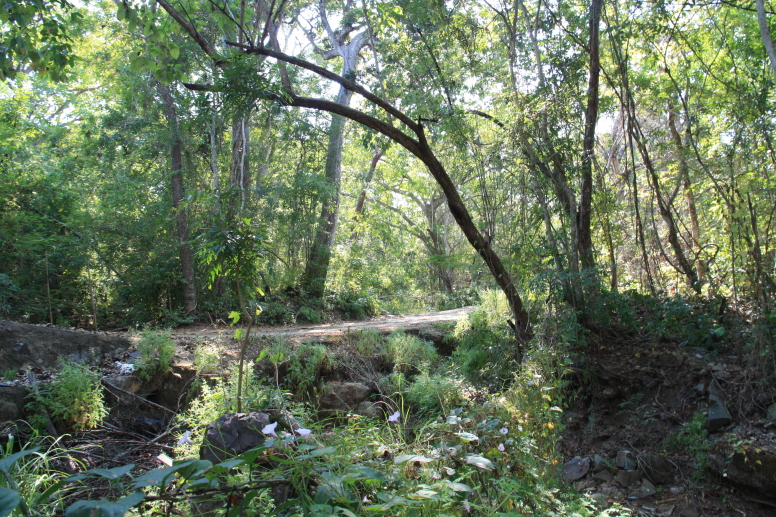
Brachypelma
boehmei habitat, subtropical dry forest and thorn brush, north of Ixtapa, Guerrero state, Guerrero state, Mexico. Photo: Stuart J. Longhorn.